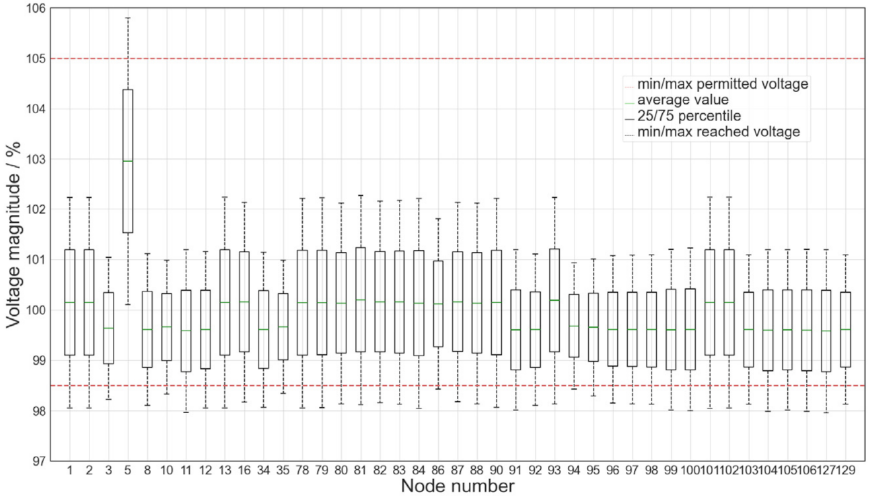
Figure 5. Voltage magnitude on some nodes of the MV grid before grid